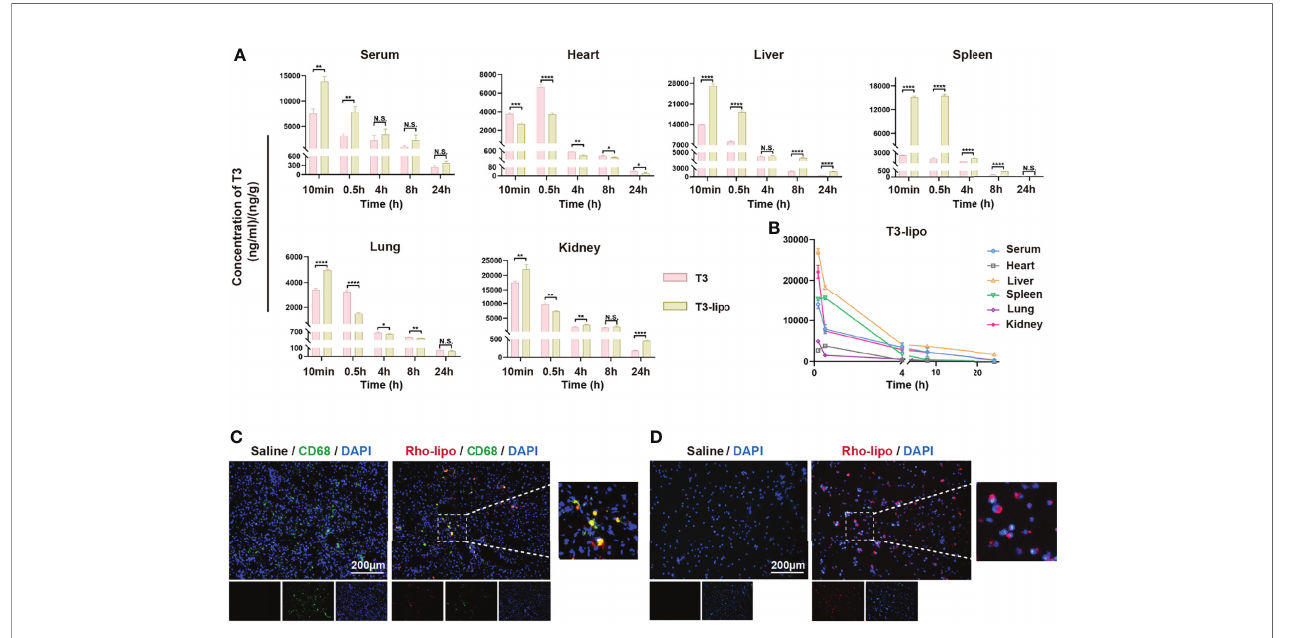
FIGURE 4 | T3-lipo are taken by hepatic macrophages and enriched in the liver. (A) Concentration – time pro fi les of T3 in serum, heart, liver, spleen, lung, and kidney after i.v. administration of T3 and T3-lipo at a dose of 5 mg/kg in DEN-induced primary HCC rat models. (B) Concentration – time pro fi les of T3 in serum, heart, liver, spleen, lung, kidney after i.v. injected with T3-lipo at a dose of 5 mg/kg in DEN-induced primary HCC rat models. n = 3 rats per group. Three independent experiments were performed for all data. Differences were analyzed using Student ’ s t -test (*p < 0.05, **p < 0.01, ***p < 0.001, and ****p < 0.0001; N.S., not signi fi cant). (C) Frozen section immuno fl uorescence of rat liver tissues after intravenous injection of saline or Rho-T3 liposome (5 mg/kg) for 30 min in DEN-induced primary HCC rat models. (D) The fl uorescence microscopy images of rat peritoneal macrophages incubated with saline or Rho-T3-lipo (10 ug/ml) for 30 min at